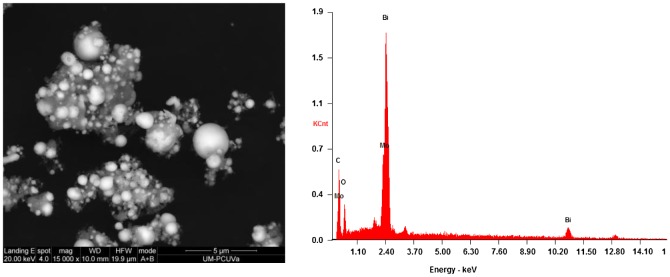
SEM micrograph (left) and EDS analysis (right) of S4 (Bi/Bi2MoO6/g-C3N4) composite.